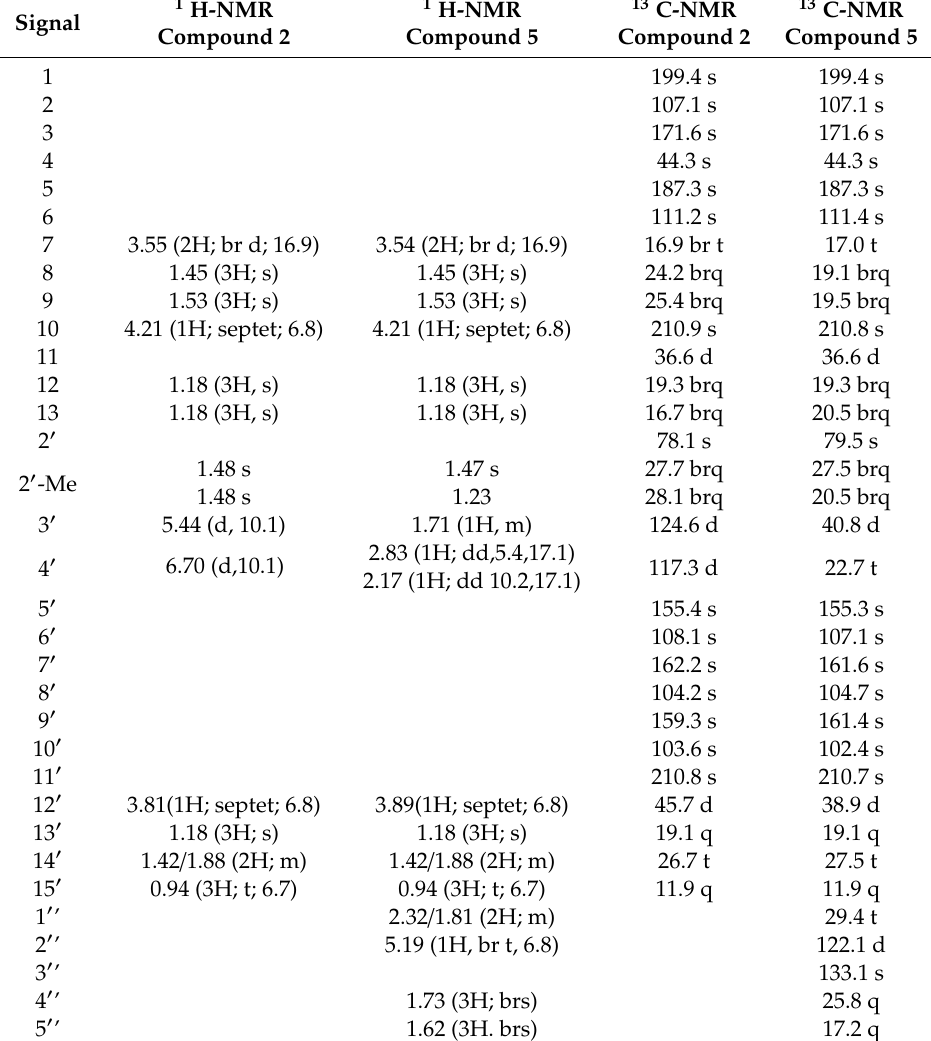
Table 4. NMR spectroscopic data for compounds 2 and 5 (400 MHz, CDCl 3 ,